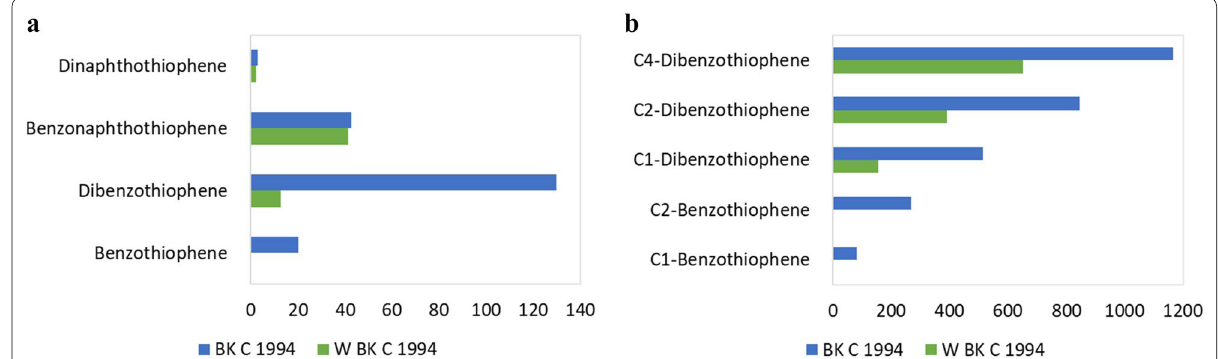
Fig. 3 a Visual representation of weathered and un-weathered concentrations (µg/mL) for the PASHs in BK C 1994. b Visual representation of weathered and un-weathered concentrations (µg/mL) for the APASHs in BK C